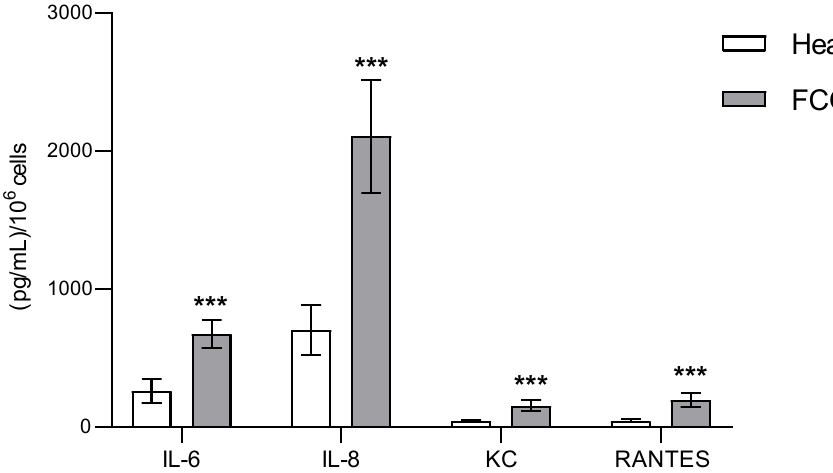
Figure 1. Cytokines detected in the fAd-MSC-derived secretomes from healthy and FCGS cats. The obtained values were normalized per 10 6 cells. Note: *** p < 0.001.